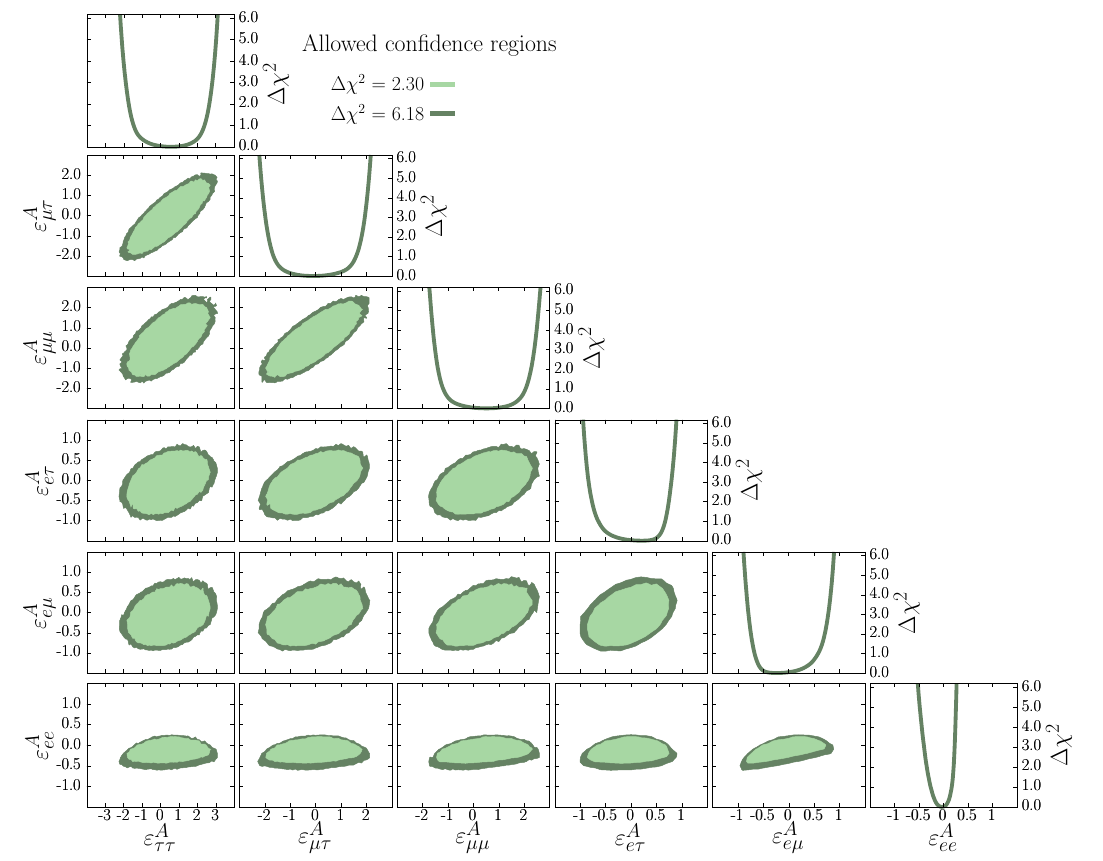
= − ε R ). The central panels show the two- αβ αβ